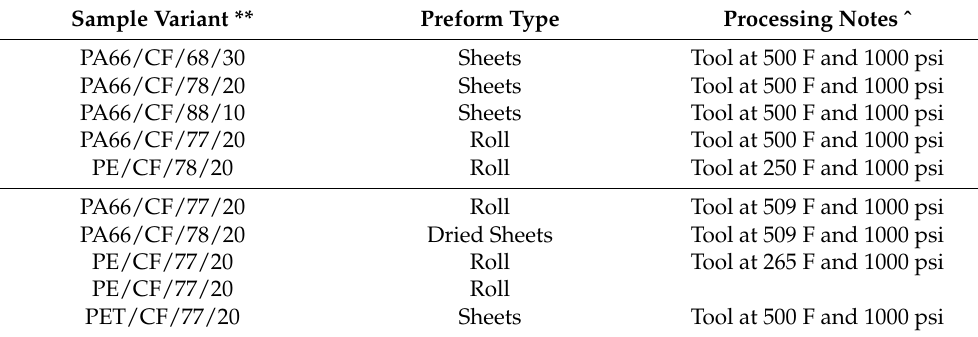
Table 1. Sample variants, preform type and processing conditions for Batch 1